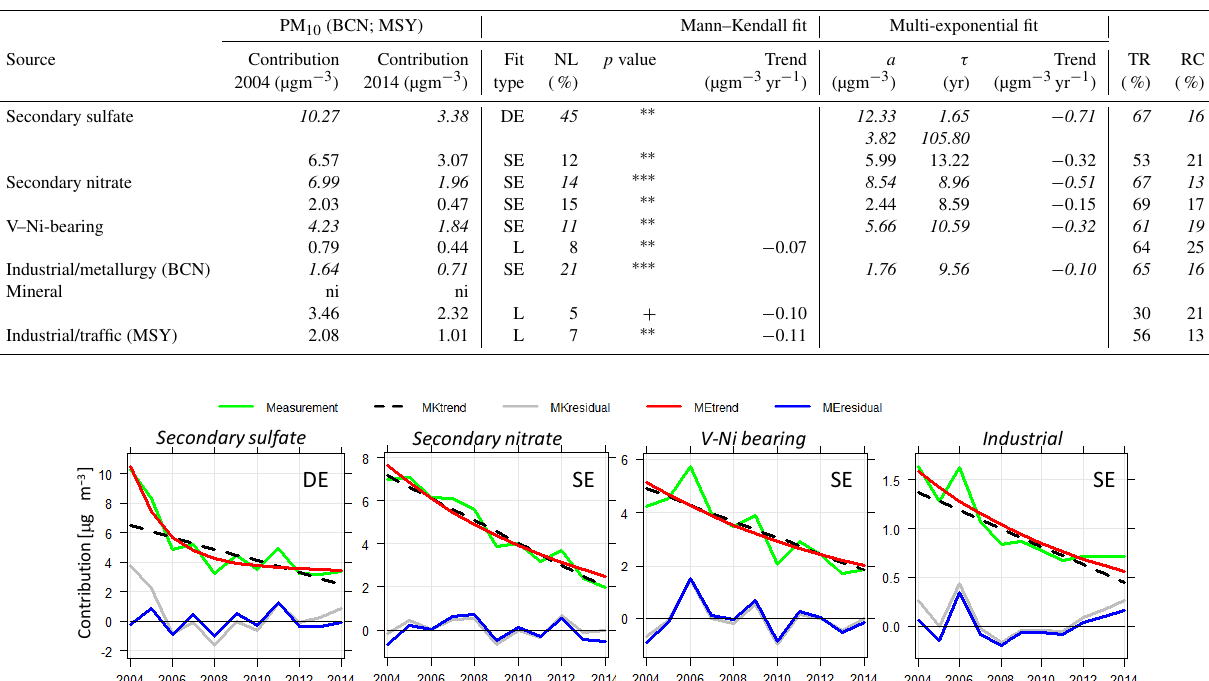
Table 4. Mann–Kendall and multi-exponential trends of source contributions in PM 10 from PMF at BCN (italic) and MSY. Type: linear (L), single exponential (SE), double exponential (DE); a (µgm − 3 ) and τ (yr) are the constants and the characteristic times, respectively, of the exponential data fittings; NL (%) is the nonlinearity; TR (%) is the total reduction; RC (%) is the residual component; ni denotes not included. Significance of the trends following the Mann–Kendall test: ∗∗∗ ( p value<0.001), ∗∗ ( p value<0.01), ∗ ( p value<0.05), + ( p value<0.1).